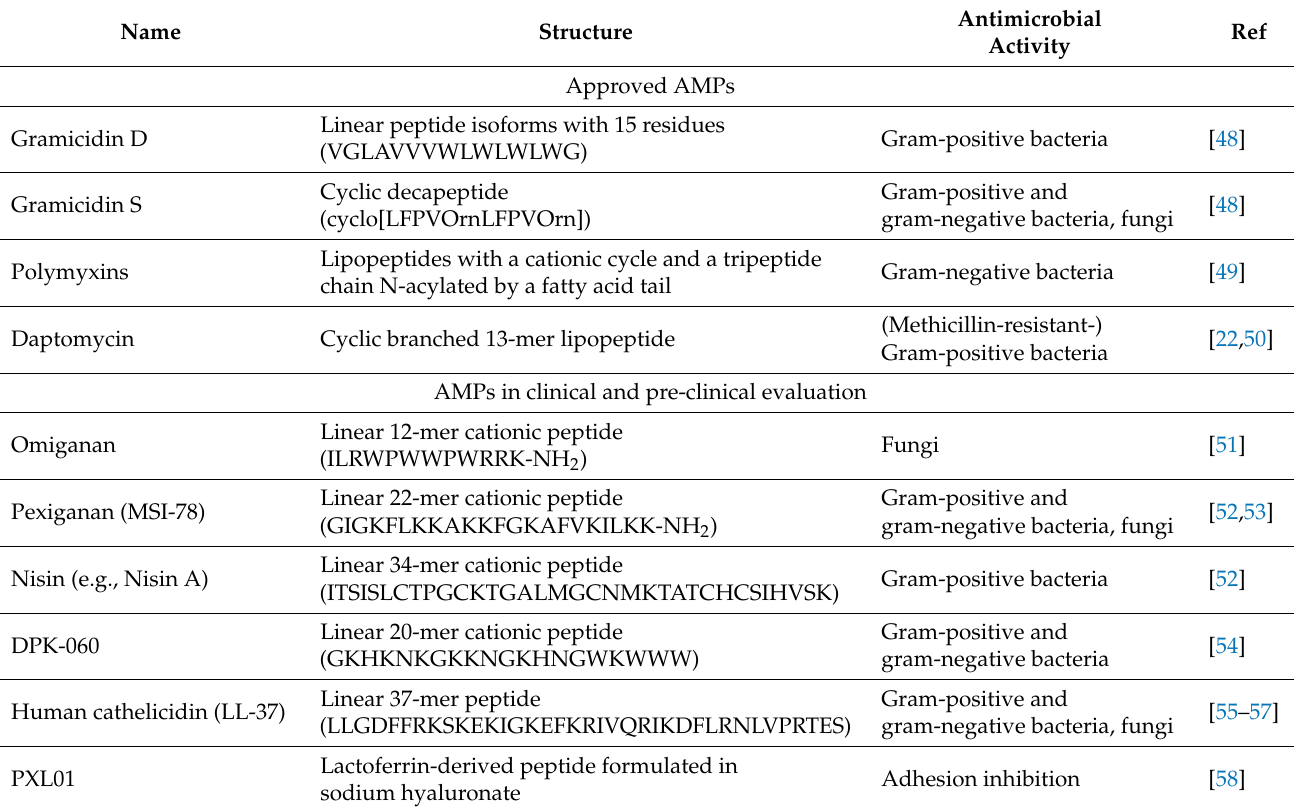
Table 1. Examples of AMPs in clinical practice and/or clinical and pre-clinical